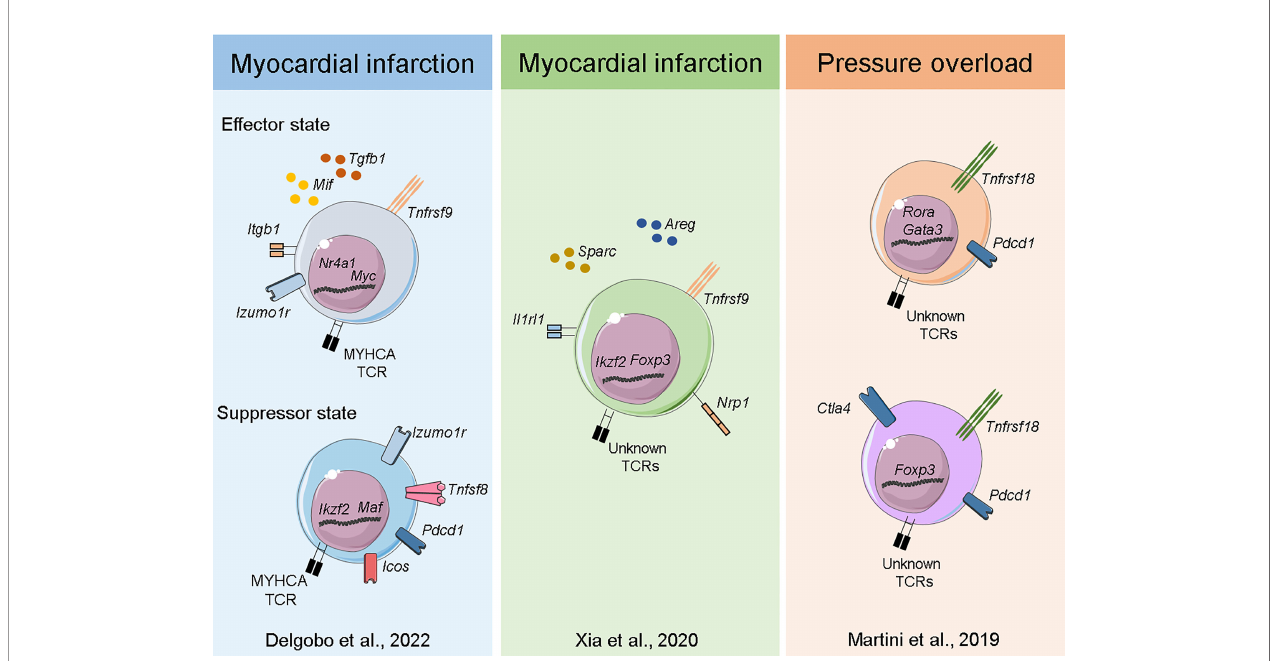
FIGURE 3 | Transcriptome of myocardial Tregs in the injured heart. Single-cell sequencing of heart and MedLN T-cells after MI (40) Delgobo et al., 2022 revealed that TCR-M cells have an induced Treg signature characterized by effector-state Tregs expressing high levels of Tgfb1 and suppressor cells expressing several immune checkpoint receptors (e.g. Pdcd1, Icos, Tigit ). Single-cell and bulk RNA sequencing of cardiac T-cells after MI (44) Xia et al., 2020 showed Treg clonal expansion, a Treg thymus-derived signature and the production of pro-healing transcripts such as Areg and Sparc . Single-cell sequencing of myocardial leukocytes in a pressure overload model (48) Martini et al., 2019 demonstrated that two main Treg populations expanded one week post injury. Both bona fi de Tregs and those with T H 17/non-lymphoid gene signatures were identi fi ed, and both expressed high levels of Pdcd1 immune checkpoint